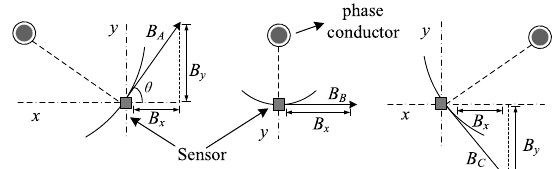
Fig. 2 Magnetic field distribution at the